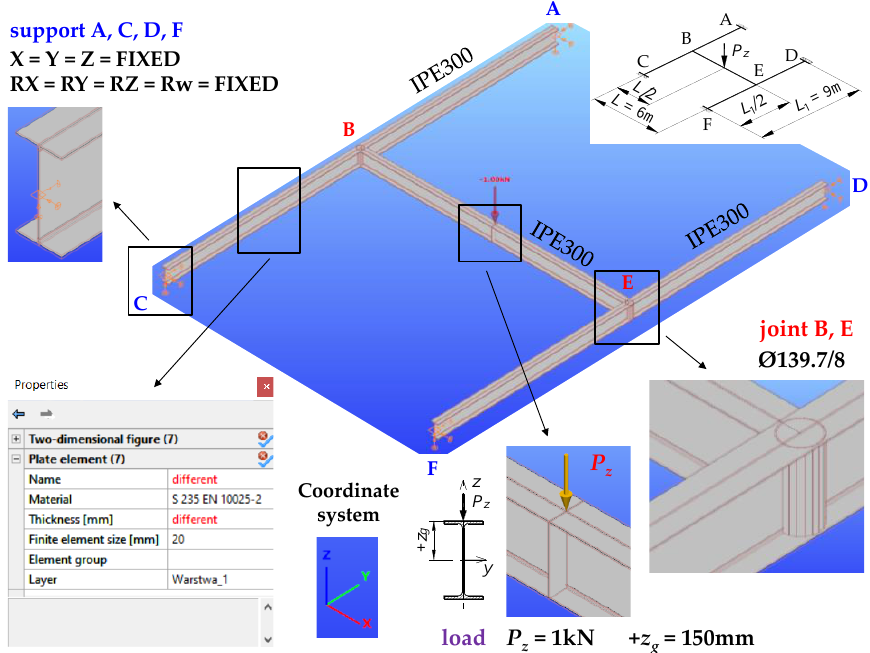
Figure 4. The spatial model of exemplary H-grillage obtained with ConSteel after the conversion to shell elements.